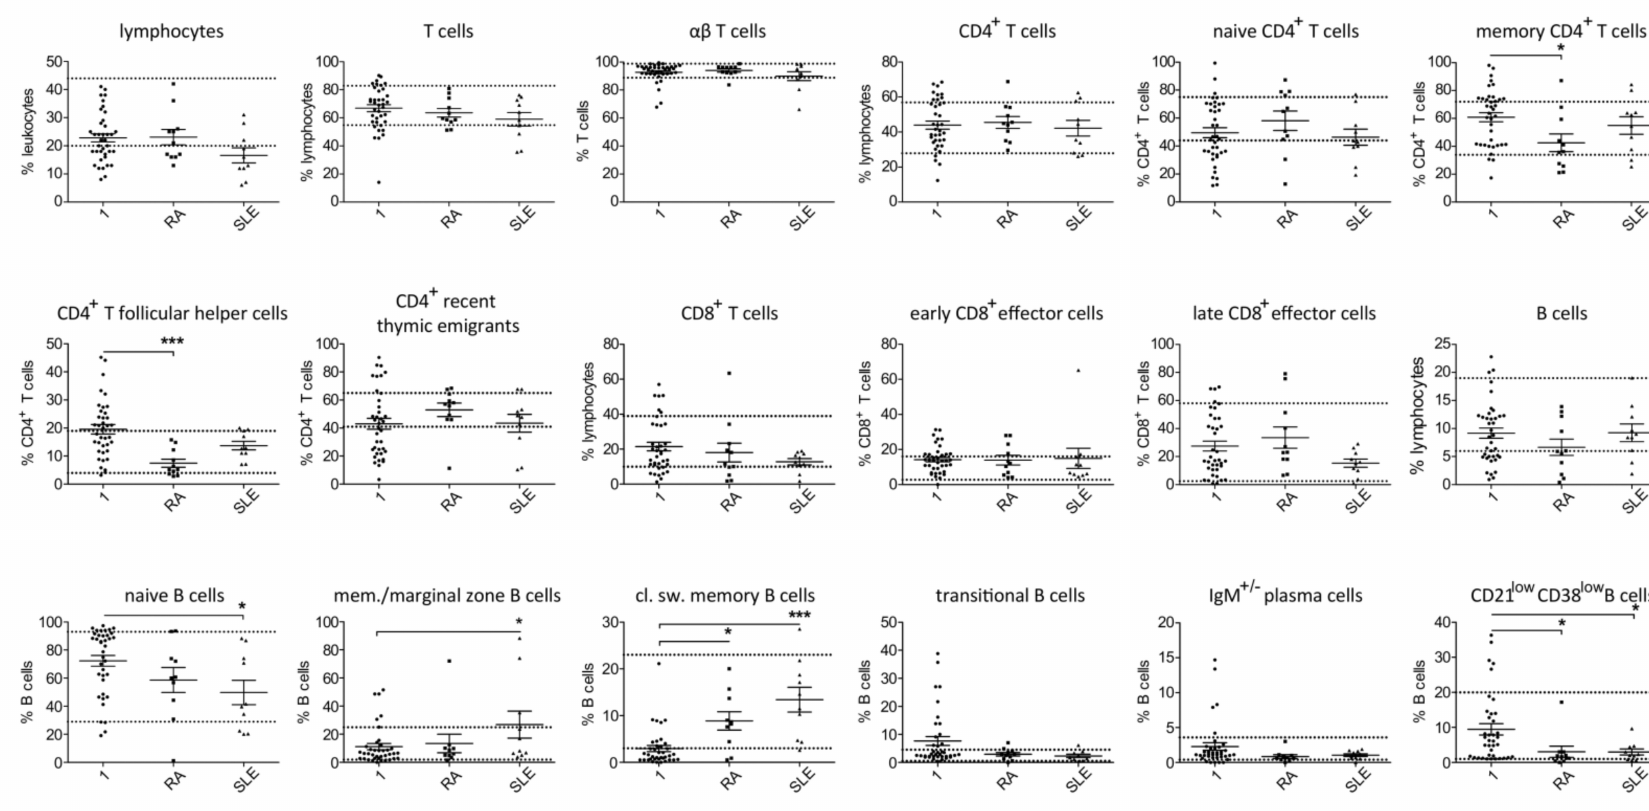
Figure 3. Comparison of T and B cell subsets in patients with primary (1) and secondary hypogammaglobulinemia with RA ( n = 11 and n = 10 in case of B cell subsets, as a patient’s (pat. nr. 37) B cells could not be di ff erentiated due to their very low count) and SLE ( n = 10). (A) Normal range values lie within the doted lines (* p < 0.05; *** p <